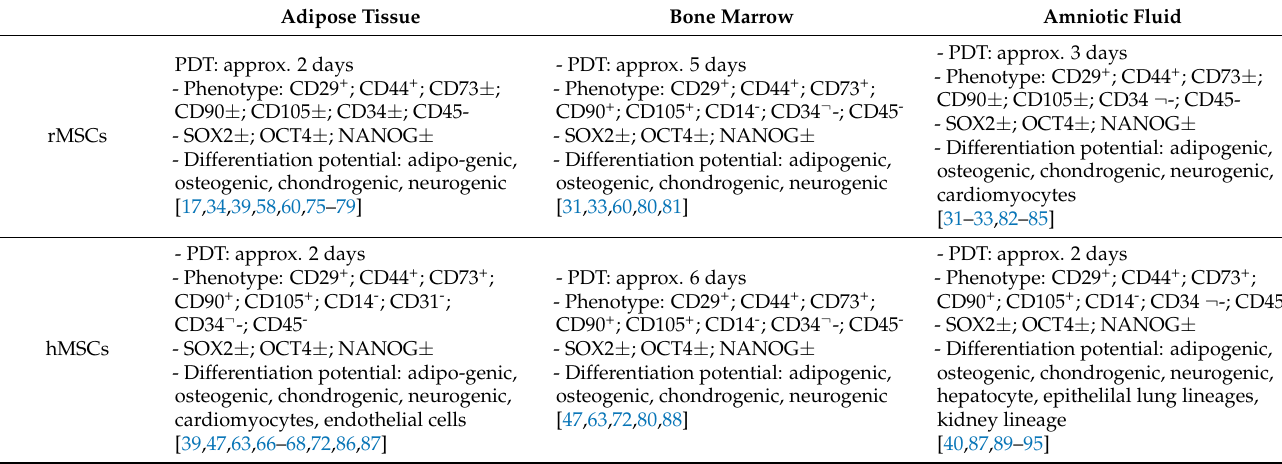
Table 7. Summary of characteristic features of rabbit and human mesenchymal stem cells from different tissues. Adipose Tissue Bone Marrow Amniotic